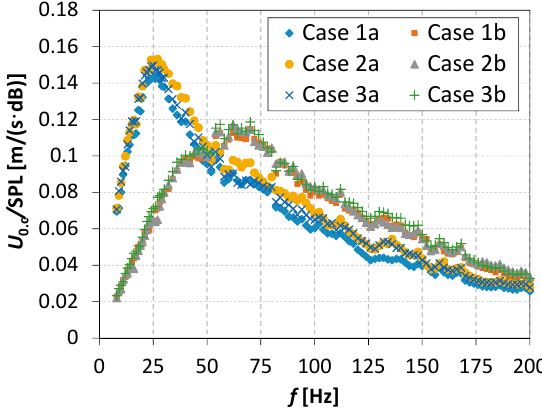
Figure 9. The ratio of the momentum velocity at the orifice axis to the SPL as a function of frequency at constant apparent power of P = 4 W.